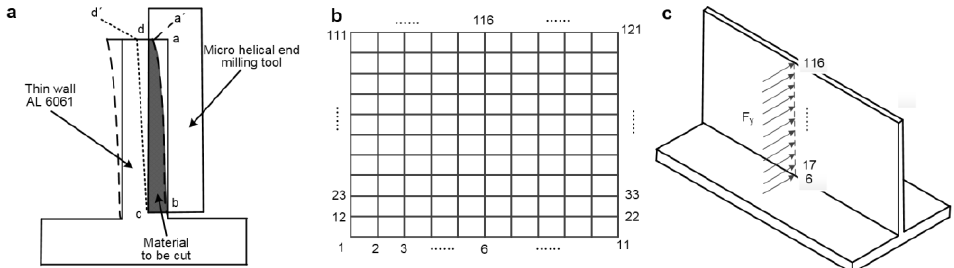
Figure 4. Micro thin-walled milling model: ( a ) error analysis of the micro thin-walled structure; ( b ) distribution of calculation points; ( c ) distribution of milling force.